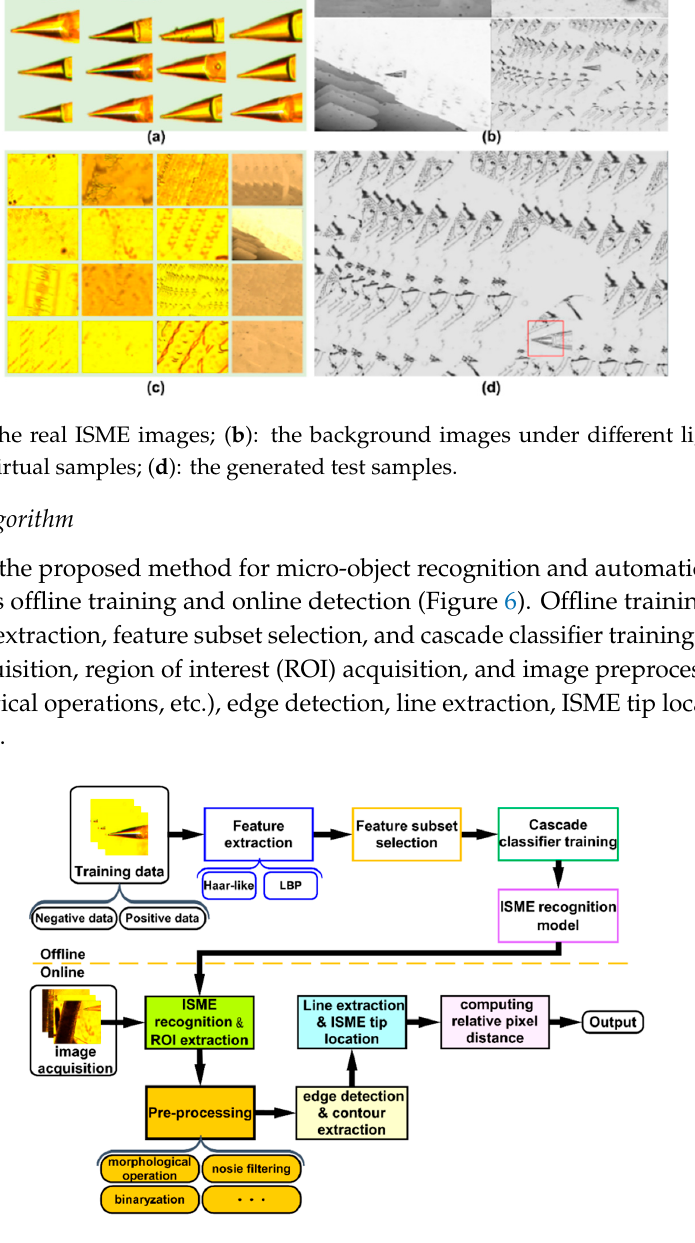
Figure 6. The flowchart of machine learning-based ISME recognition and relative distance computation.